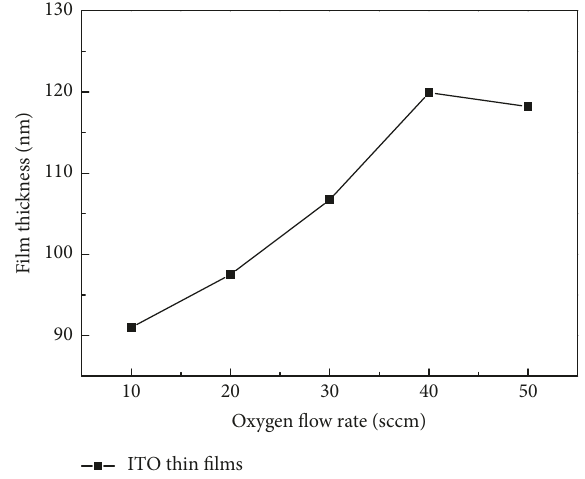
Figure 4: Film thickness as a function of oxygen flow